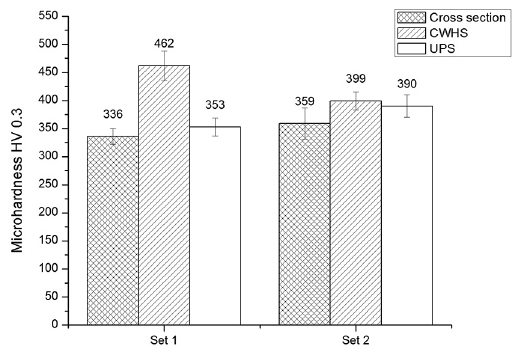
Figure 8: Vickers microhardness measured at the surface of UPS and CWHS specimens and at the cross-section, unaffected by the cold work hardening at the surface maximum erosion rate for sets 1 (~32%) and 2